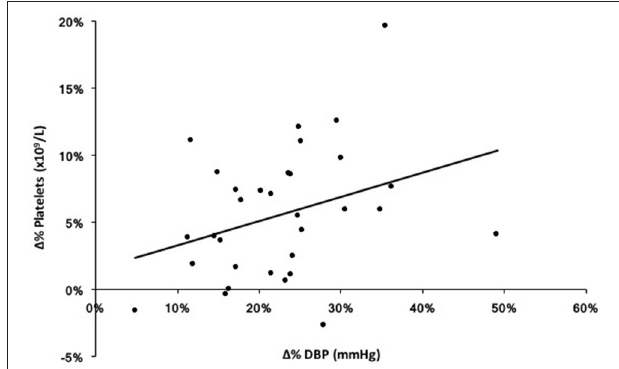
FIGURE 4 | Exploratory correlation between percent change ( 1 %) in diastolic blood pressure (DBP) and platelets in response to both ME and SE (pooled exercise condition). r = 0.363, p <